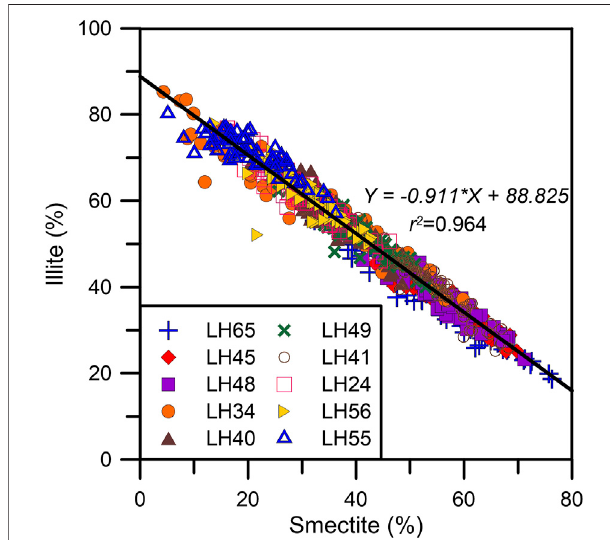
FIGURE 6 | Relationship between the content of the two major clay minerals, illite and smectite.